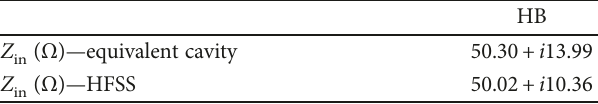
Figure 14: Input impedance of the HB antenna. Table 6: Input impedance at 2.45 GHz.